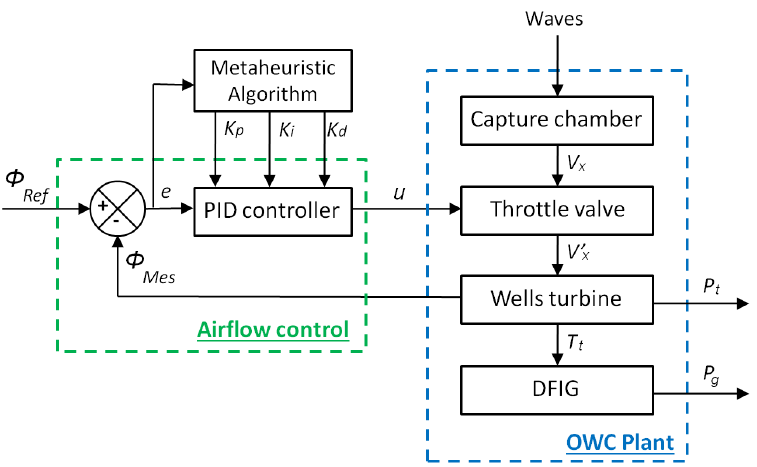
Figure 11. Advanced metaheuristic-based airflow control scheme for